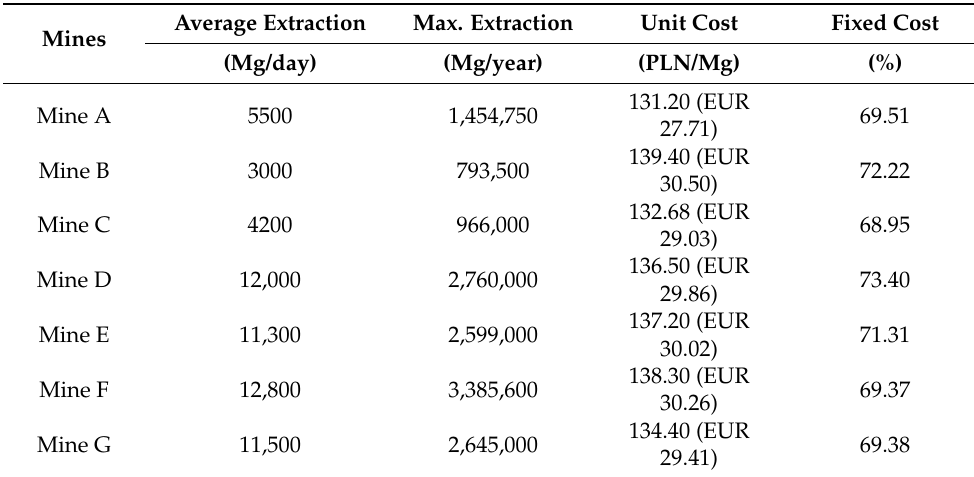
Table 1. Technical and economic coefficients for mines.